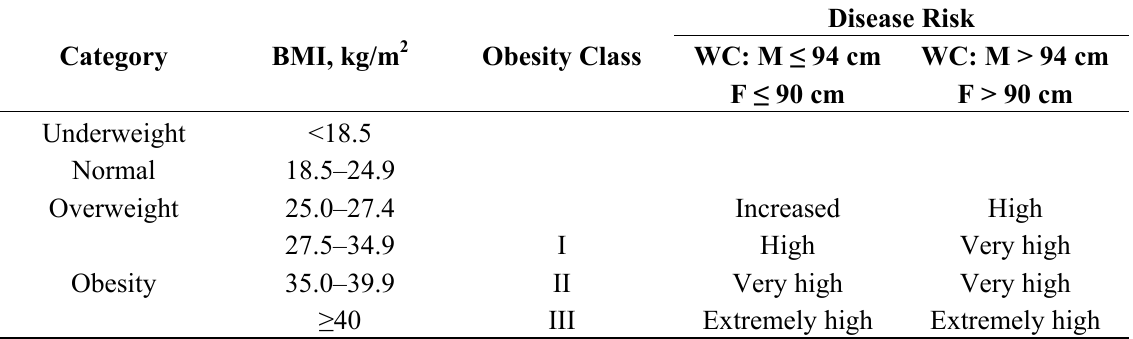
Table 4. Classification of body composition by BMI, waist circumference and disease risk for Venezuelans